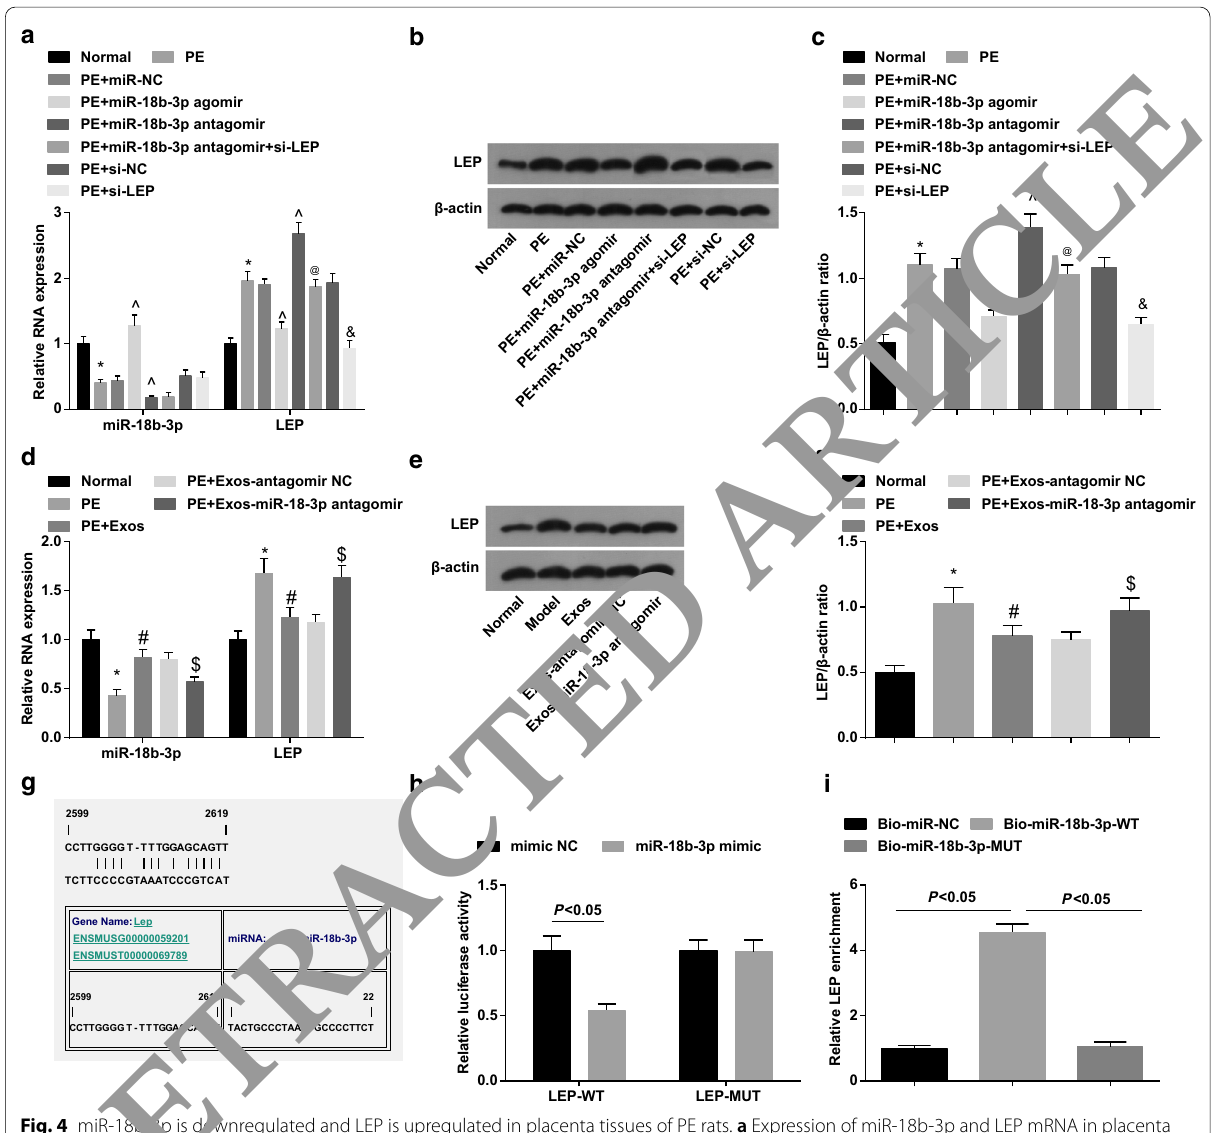
Fig. 4 miR-18b-3p is downregulated and LEP is upregulated in placenta tissues of PE rats. a Expression of miR-18b-3p and LEP mRNA in placenta tissues was detected using RT-qPCR. b Protein band of LEP in placenta tissues. c Western blot assay was conducted to detect LEP protein expression in placenta tissues. d Expression of miR-18b-3p and LEP mRNA in placenta tissues after exosome treatment was detected using RT-qPCR. e Protein band of LEP in placenta tissues after exosome treatment. f Western blot assay was performed to detect LEP protein expression after exosome treatment. g The binding sites of miR-18b-3p and LEP predicated by an online software. h The target relationship between miR-18b-3p and LEP verified by dual-luciferase reporter gene assay. i targeting relationship between miR-18b-3p and LEP verified by RNA pull-down assay. n 10, = * p < 0.05 versus the normal group. ^ p < 0.05 versus the miR-NC group. @ p < 0.05 versus the miR-18b-3p antagomir group. & p < 0.05 versus the si-NC group. # p < 0.05 versus the PE group. $ p < 0.05 versus the PE Exos-antagomir NC group. Measurement data were depicted as mean standard + ± deviation, and comparisons among multiple groups were assessed by one-way ANOVA followed by Tukey’s